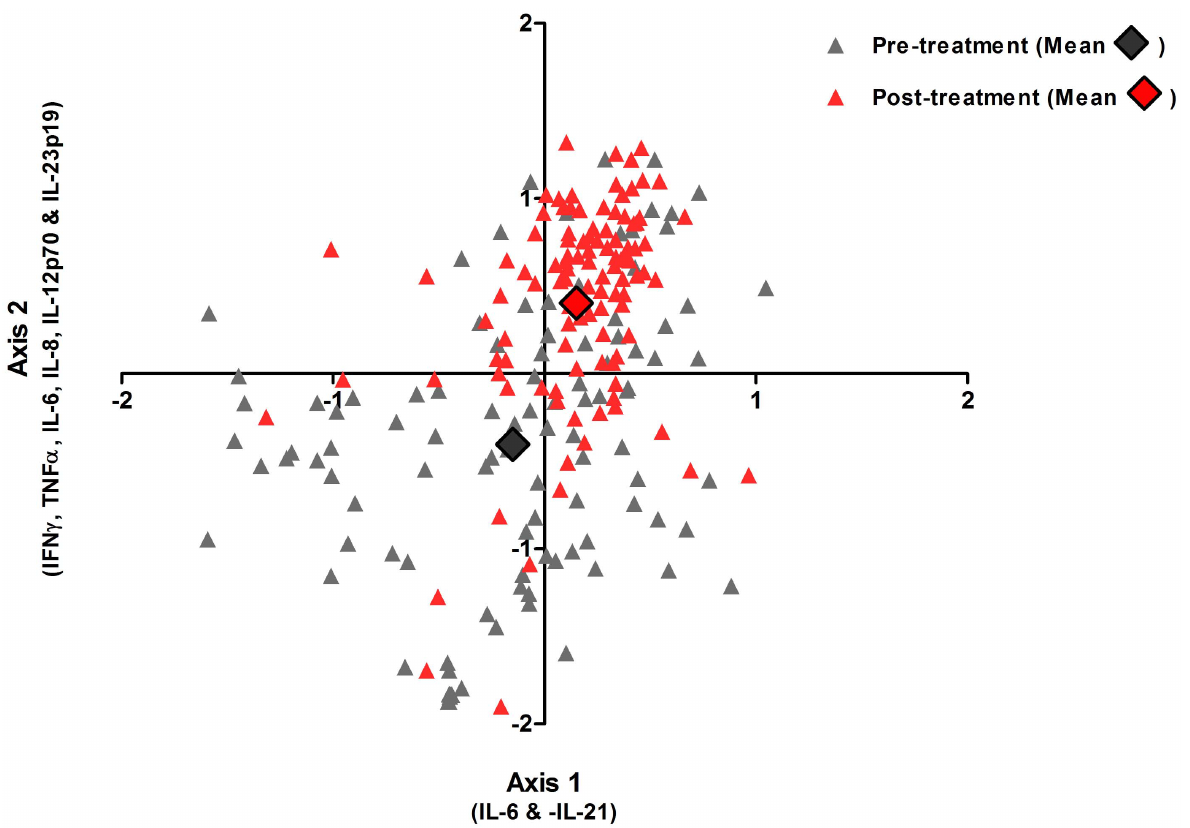
Figure 3. Relative similarity and dissimilarity in patterns of GST-specific cytokine responses before and 6 weeks after praziquantel treatment. NMS ordination plot showing Sorensen Bray-Curtis distance scores (an indicator of how a participant’s combination of 13 GST-specific cytokine responses rank relative to those of all other participants) for all participants plotted before ( grey triangles ) and 6 weeks after ( red triangles ) praziquantel treatment. Axis 1 and 2 are spatial meaning that participants positioned close together have similar patterns of cytokine responses to GST and those positioned far apart have dissimilar patterns of cytokine responses to GST. The individual cytokines that most closely correlate with each axis are indicated. Bold diamonds represent the mean pre- ( grey ) and post-treatment ( red ) scores for the study cohort (n=107).